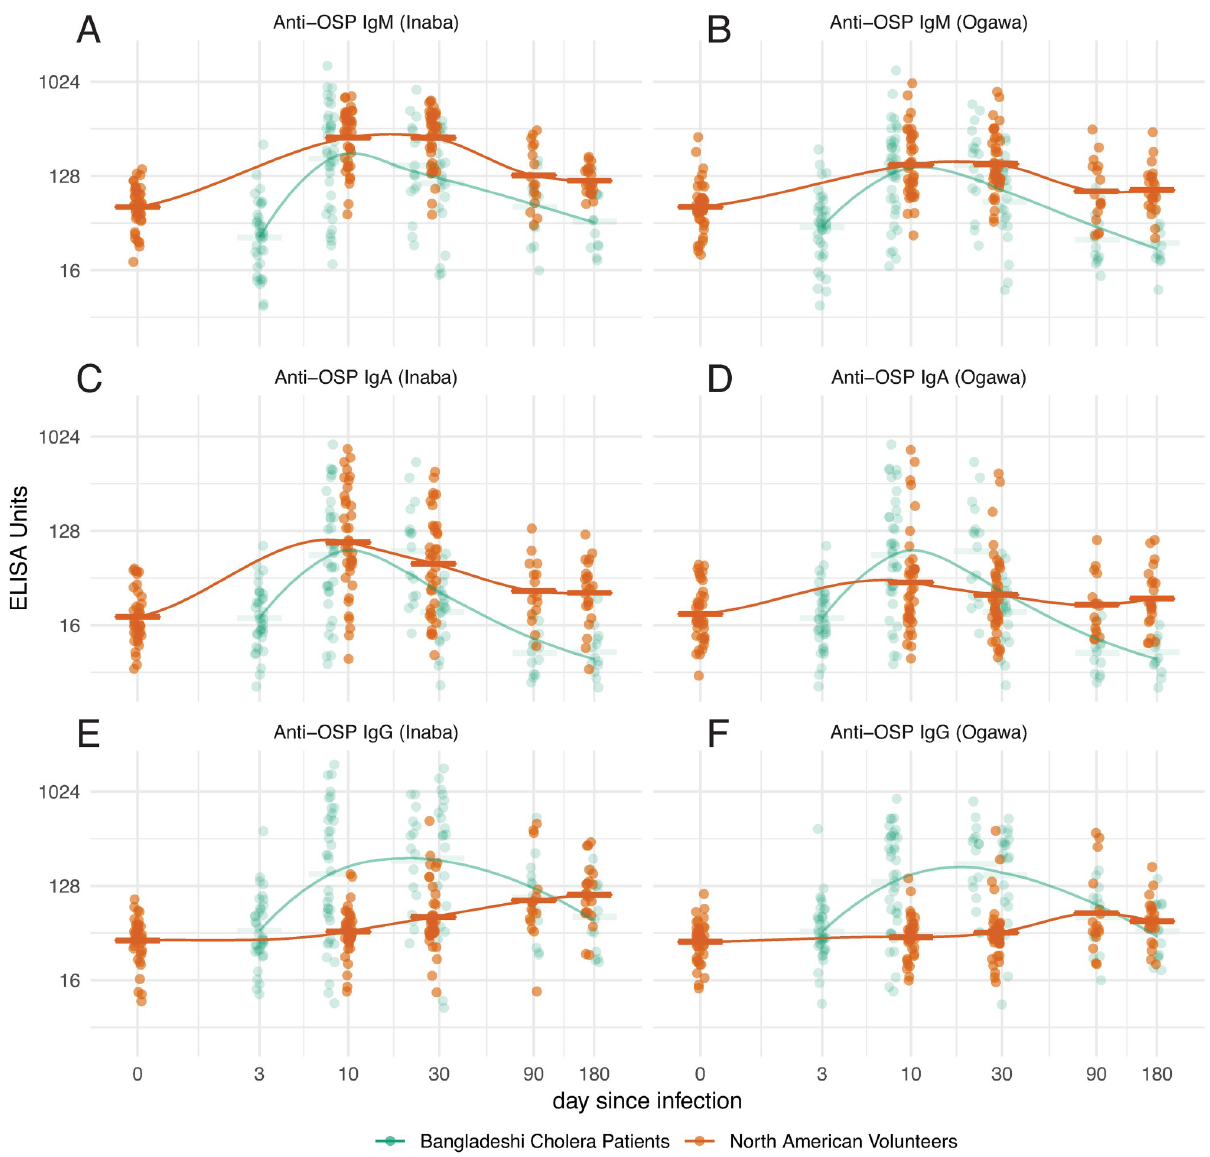
Fig 1. OSP responses over time in North American volunteers (orange) and Bangladeshi cholera patients (green). Dots represent individual responses at each time since infection (jittered) for IgM (A-B), IgA (C-D) and IgG (E-F). Initial data points for Bangladeshi samples assigned day 3 from presumed date of infection. Lines represent LOESS curve fit to response data from each group and horizontal bars represent the geometric mean titer for each time point. Please refer to Supplemental S1–S3 Figs for detailed statistical comparisons among